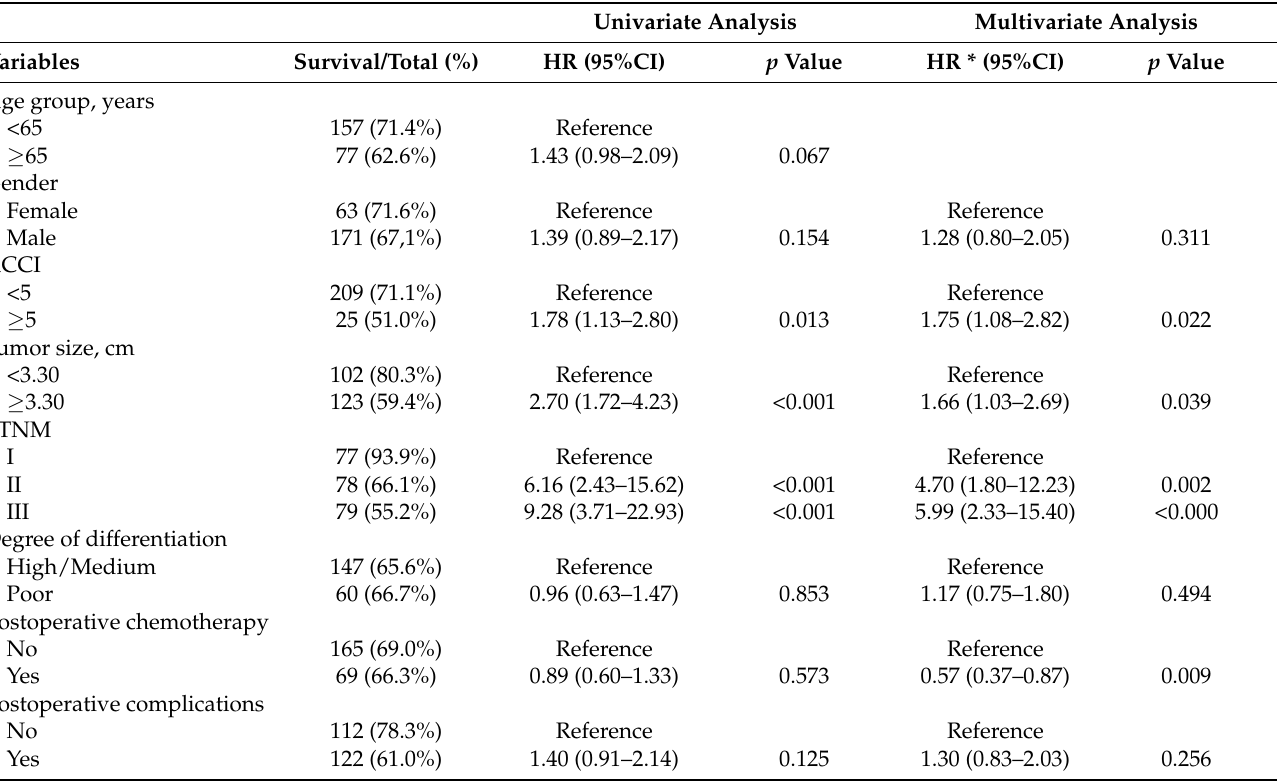
Table 4. Cox proportional hazard analysis of the prognostic predictors associated with cancer specific survival among patients with esophageal squamous cell carcinoma (n = 343). Univariate